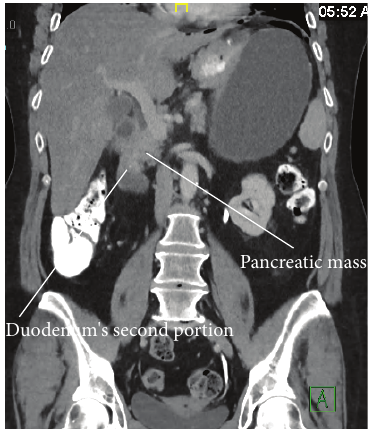
Figure 2: CT scan of abdomen demonstrating a pancreatic mass obstructing the second portion of the duodenum.